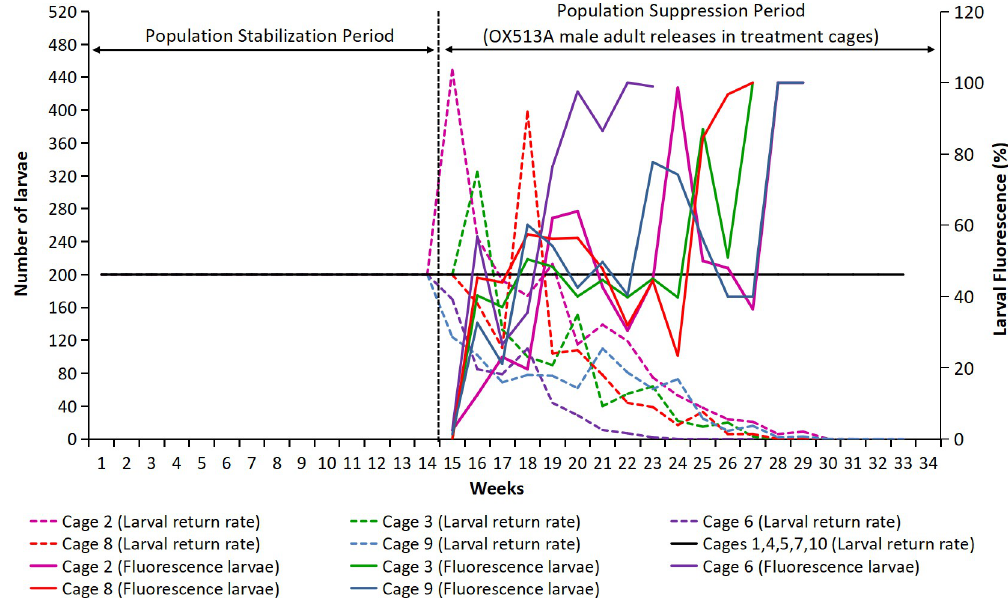
Fig 3. Weekly larval return rate in control and treatment cages before and after OX513A male adult releases and fluorescence observation. Post OX513A male adult release initiation in treatment cages and following first observation of introgression of OX513A based on fluorescence screening of progeny, the larval return rate was calculated for the treatment cage in proportion to paired control cage.